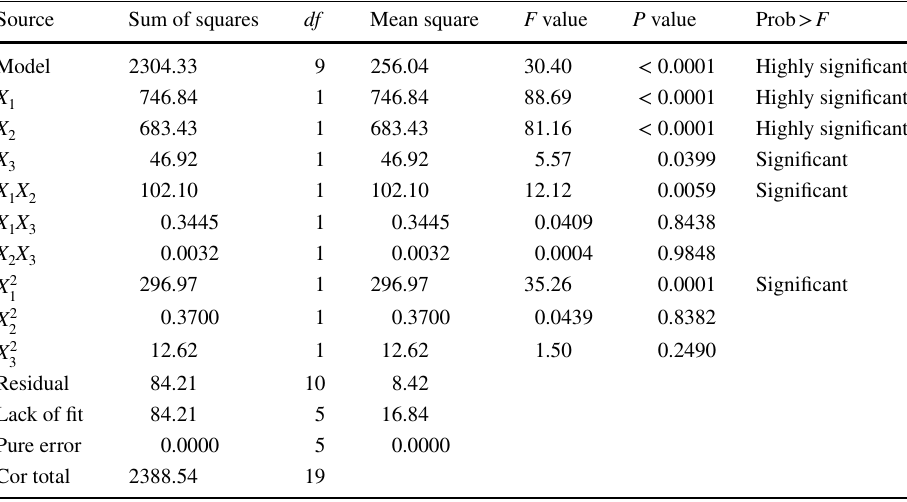
Table 9 ANOVA of the second- order polynomial equation for power consumption, (kWhr/m 3 )